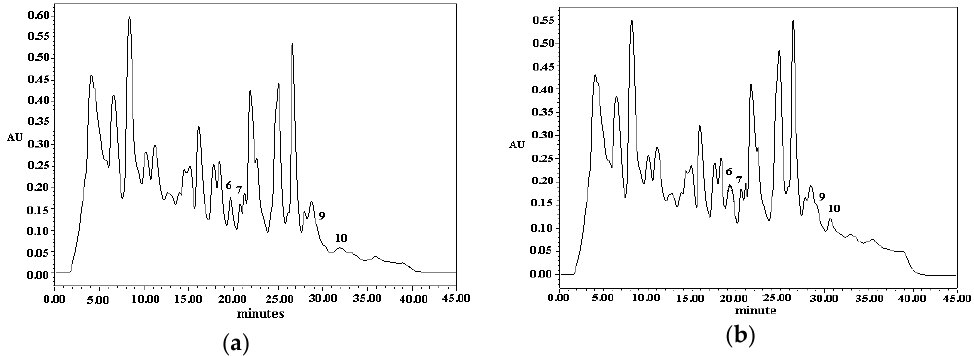
Figure 5. HPLC chromatograms of ( a ) sugar cane juice extracts; ( b ) spiked sugar cane juice extracts by IAA, 3-acetylindole, IPA and indole-2-carboxylic acid at 280 nm. Note: Injection volume was 10 μL. Sugar cane juice extracts were purified earlier using C 18 SPE column (Section 2.5). HPLC running conditions and peak identities were the same as described in Figure 2. Table 4. Estimated concentrations of 10 indoles in sugar cane juice, recoveries of 10 indoles for SPE procedure and estimated original concentrations of 10 indoles in sugar cane juice.